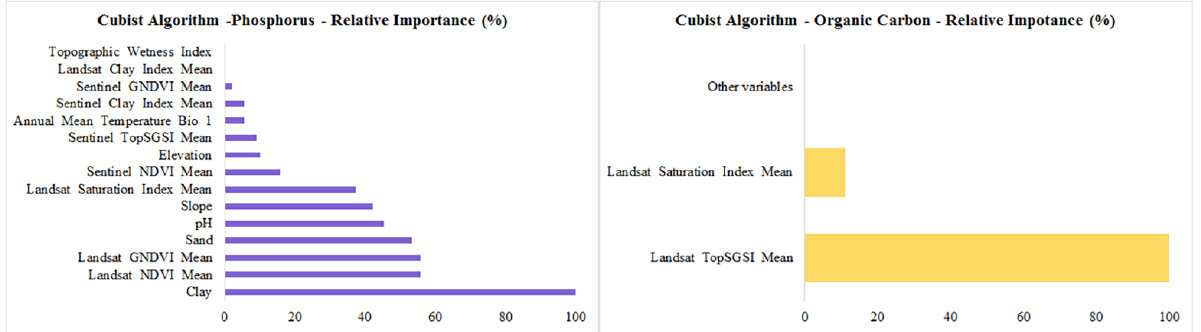
Figure 7. Variable importance. at left for phosphorus using Cubist; at right for organic carbon using Cubist (X axis: percent relative importance).